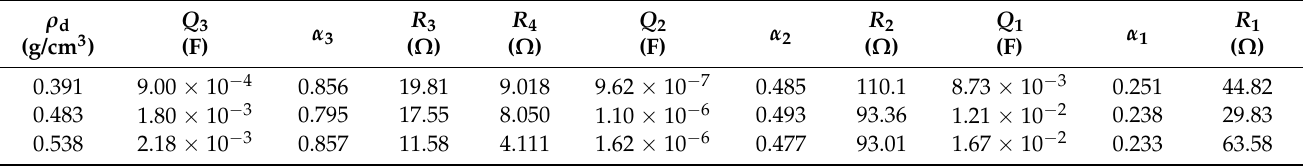
Table 4. Variation in equivalent circuit parameters of substrates affected by dry density